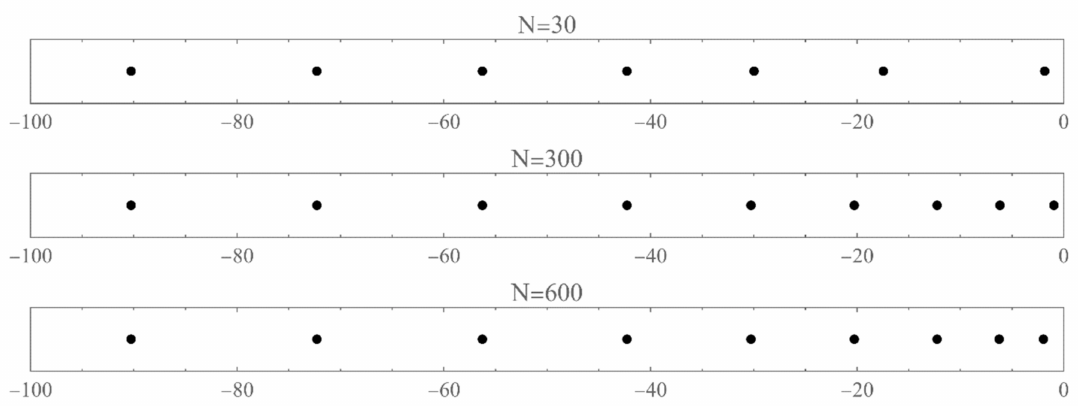
Figure A18. The zeros of P N ( E ) in units of λ 2 for N = 200. We took γ = 10 and µ = − 9.5. The energy bands for E ≥ 0 extend to infinity.